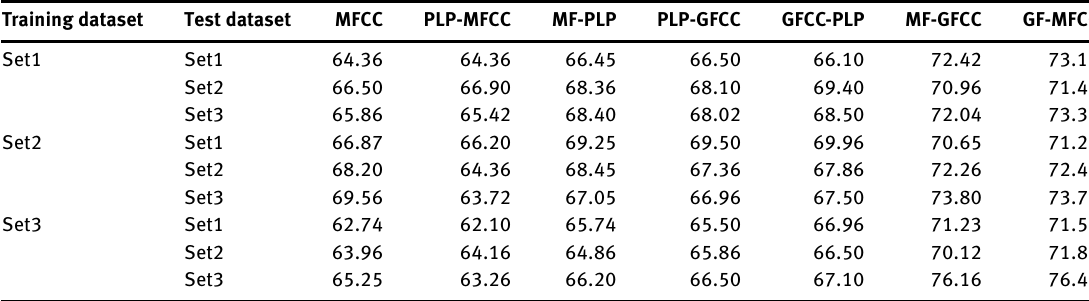
Table 1: WRr (%) of Various Feature Extraction Integrations and MFCC. Training